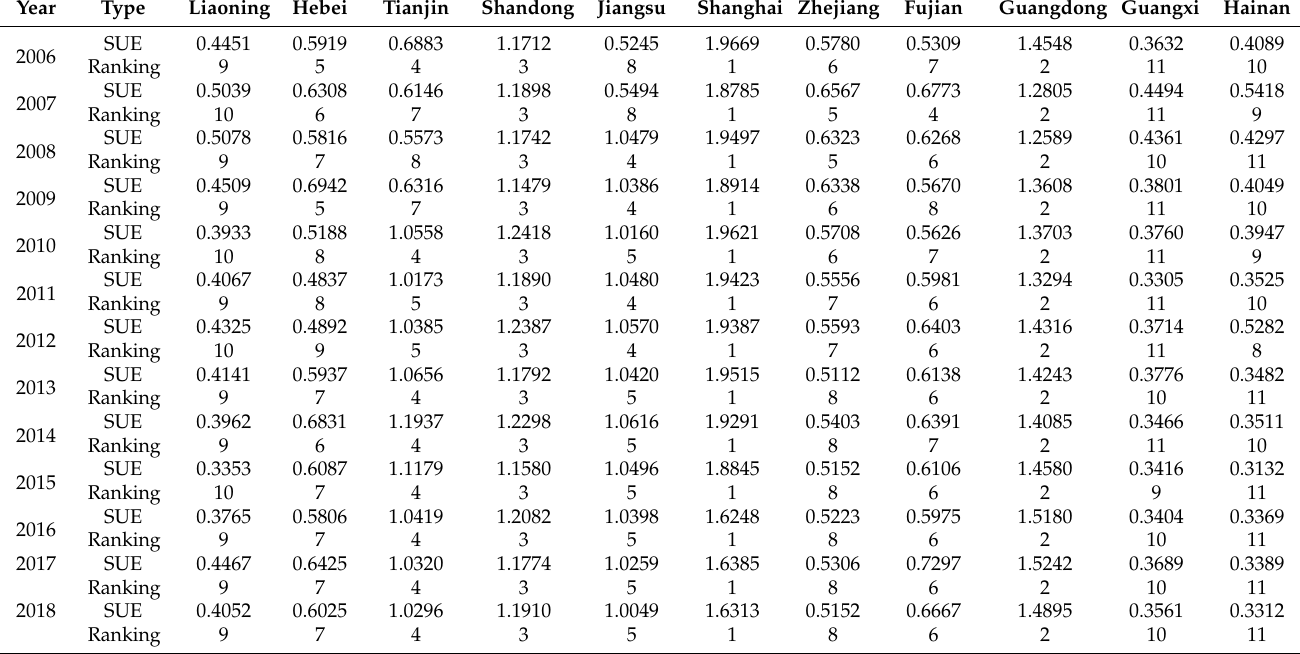
Table 2 displays in detail the measured results and the ranking of the SUE of 11 coastal provinces (cities) in China from 2006 to 2018. Referring to Wang (2014) [33], and taking into account the actual situation of China’s sea use, this paper divides coastal provinces and value < 1), inferior-efficiency regions (0.5 ≤ mean value < 0.7), and low-efficiency regions (mean value < 0.5), on the basis of the mean value of SUE. The spatial distribution is exhibited in Figure 2. Table 2. Value and ranking of SUE in coastal provinces (cities) of China, Table 2. Value and ranking of SUE in coastal provinces (cities) of China, 2006 – 2018.